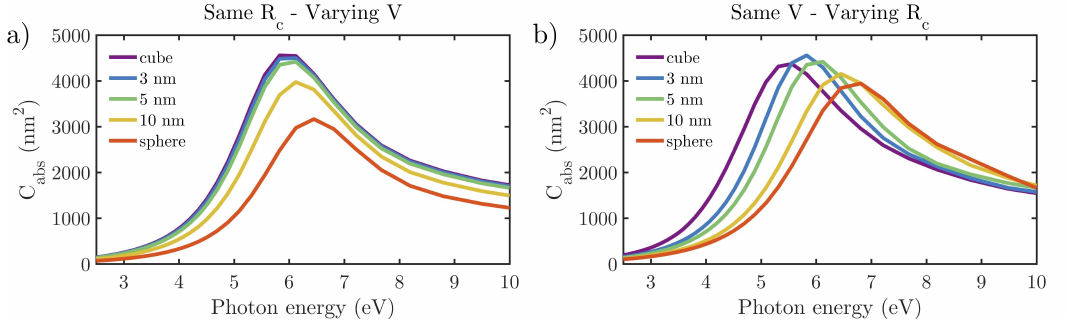
Figure 5. Absorption cross-sections ( C abs ) spectra of ( a ) cubes with R c = 5 nm with the same volume as those with L = 30 nm and R c indicated by the legend and ( b ) cubes with the same volume as a cube with L = 30 nm and R c = 5 nm, but with an R c given by the legend.